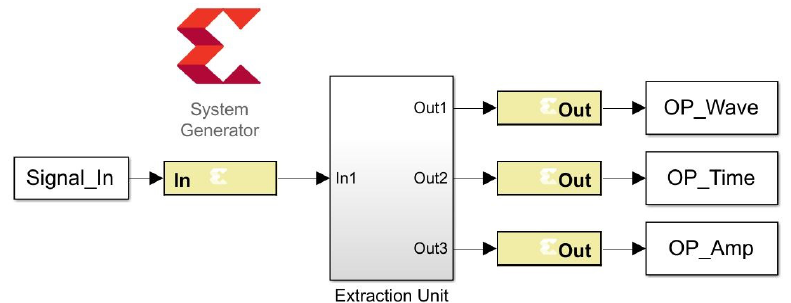
Figure 5. Design of a single-channel filtered input system (SCF) in SysGen.